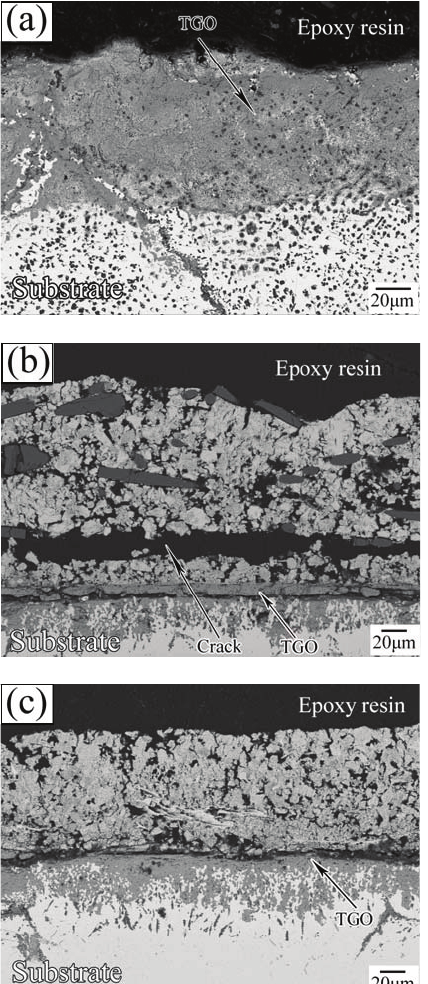
Figure 7. Cross-section micrographs of specimens with various coatings after oxidation: (a) blank (b) TBCs, and (c) TBCs with ZrO 2 /Al 2 O 3